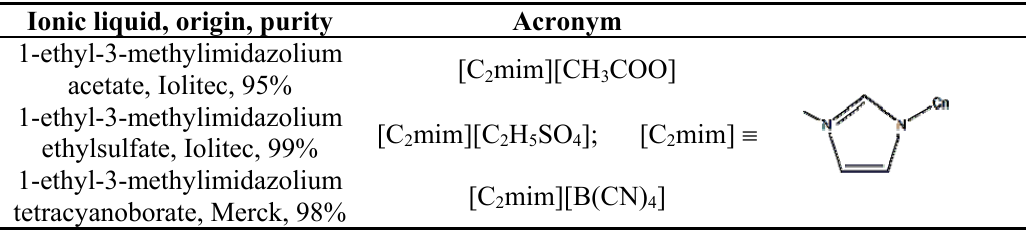
Table 1. List of ionic liquids used in the present study along with their stated purity and